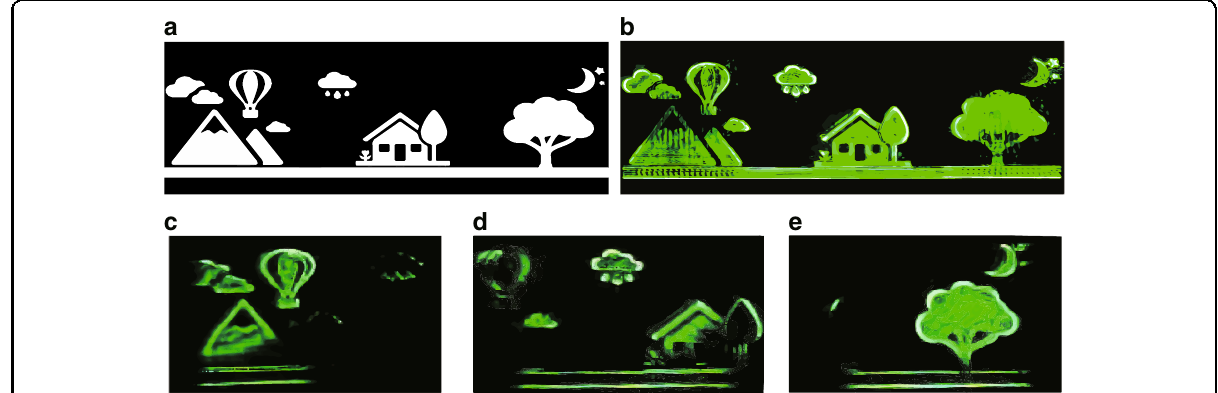
Fig. 9 Reconstructed image of the large size holographic display. a Complex scene with a resolution of 3840 × 1282. b Reconstructed image by using the proposed method. c Left marginal viewing area of the reconstructed image by using the traditional method. d Middle viewing area of the reconstructed image by using the traditional method. e Right marginal viewing area of the reconstructed image by using the traditional method